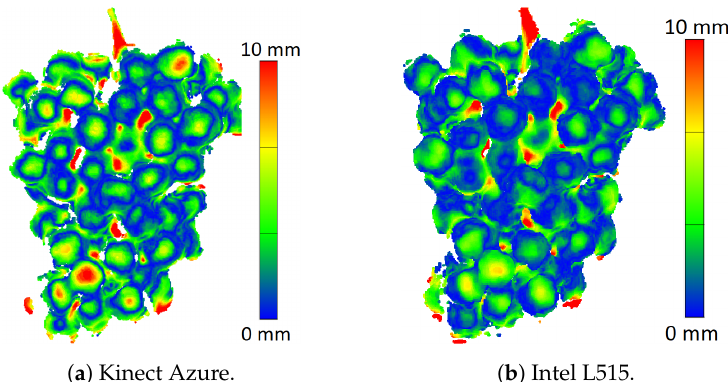
Figure 9. Kinect Azure and Intel L515 error scans for unpainted grapes after the depth camera scans were aligned with the photogrammetry reference scan using the ICP alignment method.